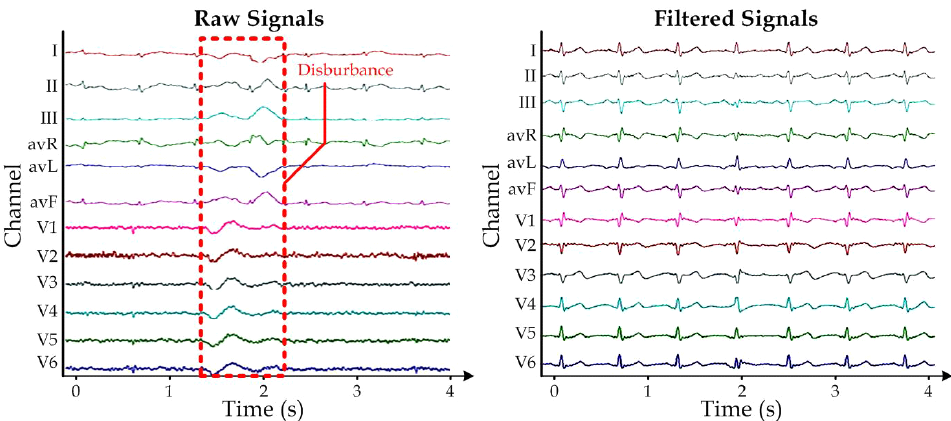
Figure 8. Representative ( a ) Raw 12-lead ECG measurement with disturbance due to body movements; ( b ) The corresponding filtered signals, which have been scaled for better